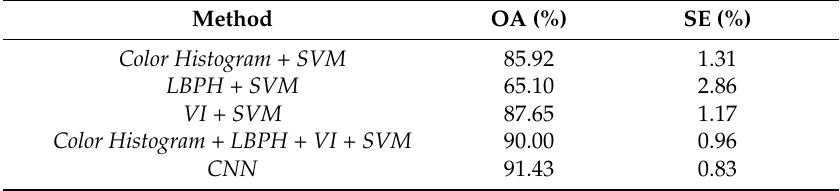
Table 5. Comparison of overall accuracy (OA) and standard error (SE) of different methods on the validation